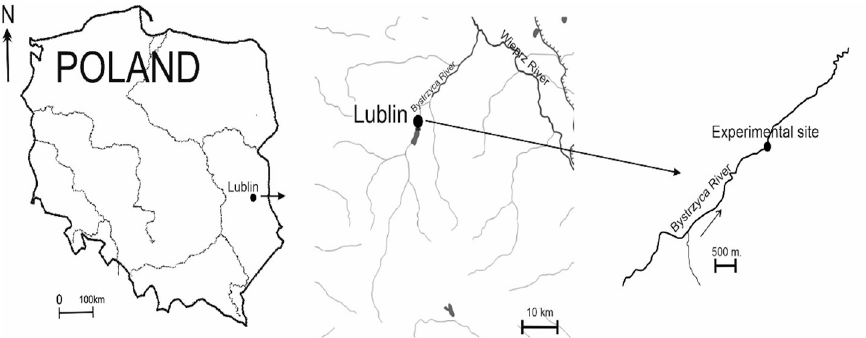
Figure 1. Location of the study area.